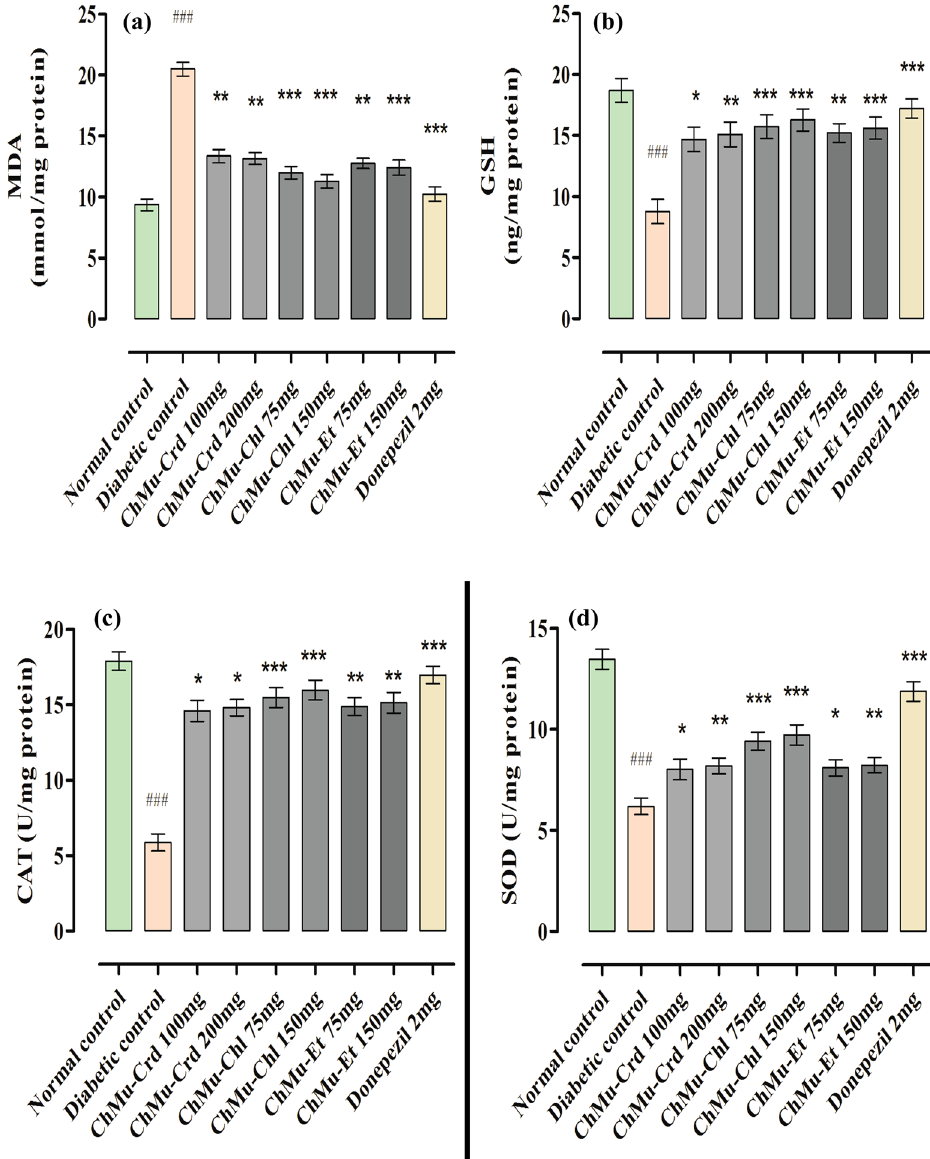
Figure 2: E ff ect of crude extract and fractions of C. murale on antioxidant enzymes and oxidative stress markers: ( a ) level of MDA, ( b ) level of GSH, ( c ) activity of CAT, and ( d ) activity of SOD. Mean ± SEM ( n = 6 ) . One - way ANOVA after which Dunnett ’ s post hoc multiple comparison test to ascertain the P - values. ### P < 0.001 comparison of STZ - treated diabetic ( amnesic ) group vs normal control, * P < 0.05, ** P < 0.01, and *** P < 0.001 as comparison of STZ - treated diabetic ( amnesic ) group vs donepezil, crude extract, and fraction - treated groups, using one - way ANOVA followed by Dunnet comparison. Crude extract ( ChMu - Crd ) , chloroform ( ChMu - Chl ) , and ethyl acetate ( ChMu - Et )